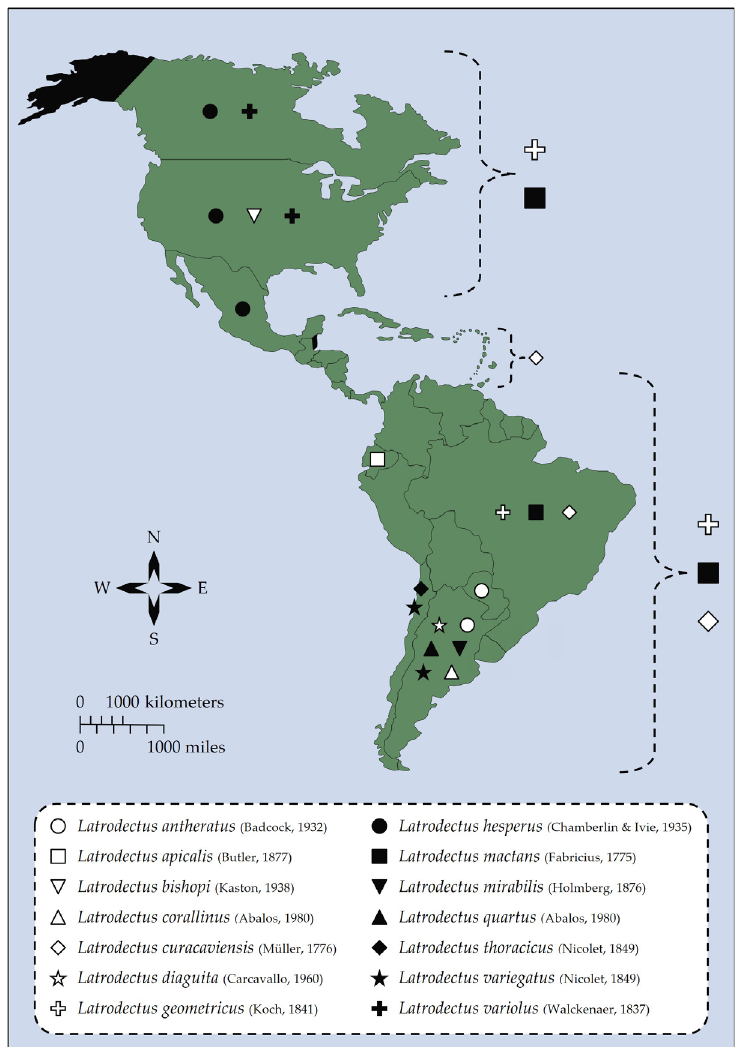
Figure 1. Geographical distribution of widow spiders in the Americas. The occurrence of fourteen Latrodectus species is currently recognized in the Americas. Symbols are placed on the countries where the presence of a given species has been reported. Brackets indicate an imprecise distribution across the continent. Latrodectus geometricus (white cross) has a wide distribution, occurring in many countries throughout the Americas. Latrodectus mactans (black square) is likely native to North America but has been introduced to South America. Latrodectus curacaviensis (white diamond) can be found in the Lesser Antilles and South America. Spiders from the Latrodectus genus have been reported in all the regions marked in green, although their identification at the species level is not always possible. No record of the presence of widow spiders is available for the regions marked in black (Belize and the state of Alaska, United States). This map is based on the list of Latrodectus species and their distribution available at The World Spider Catalog [27] as well as on the specialized literature on widow spiders, as mentioned